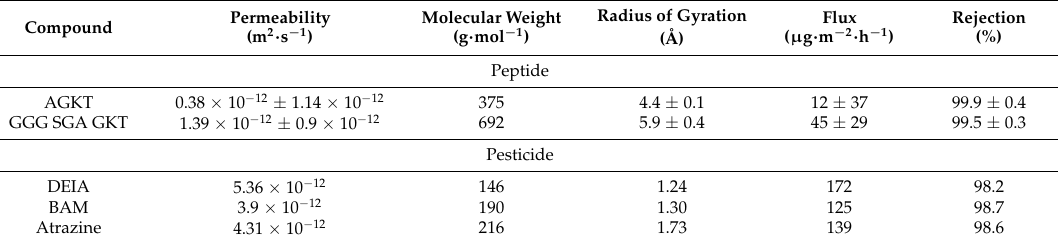
Table 1. Overview and comparison of membrane transport parameters. The table shows characterization parameters for each peptide and a comparison to three pesticides in a previous study with the same membrane [23]. The rejection values are calculated on measured permeabilities and a water flux of and the active area for the setup was 0.785 cm 2 . The flux is based on a feed concentration of 1 mg · L − 1